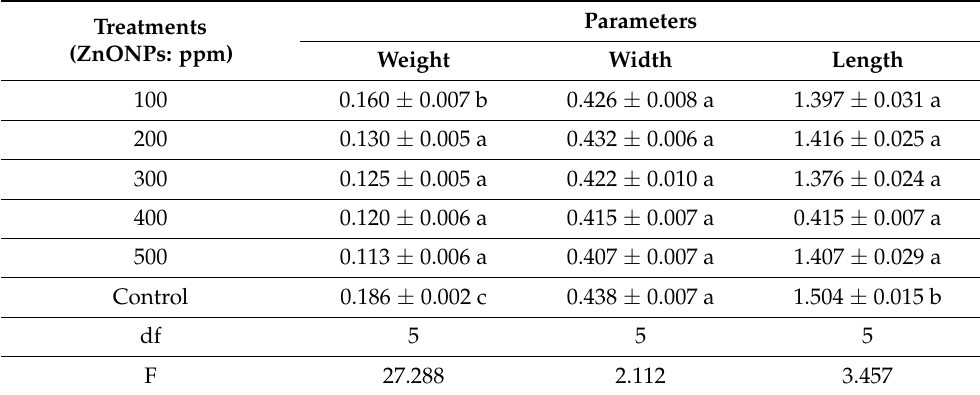
Table 2. Pupal weight, width, and Length (Mean ± SE) of FAW fed on dip food (baby-corn) in ZnO NPs different concentrations (100–500 ppm) and control.